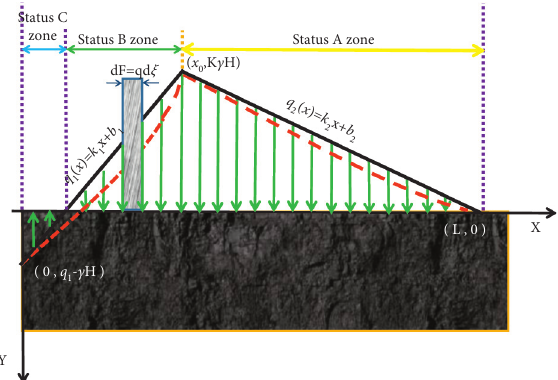
Figure 4: Mechanical model of stress calculation in zone A-B-C.